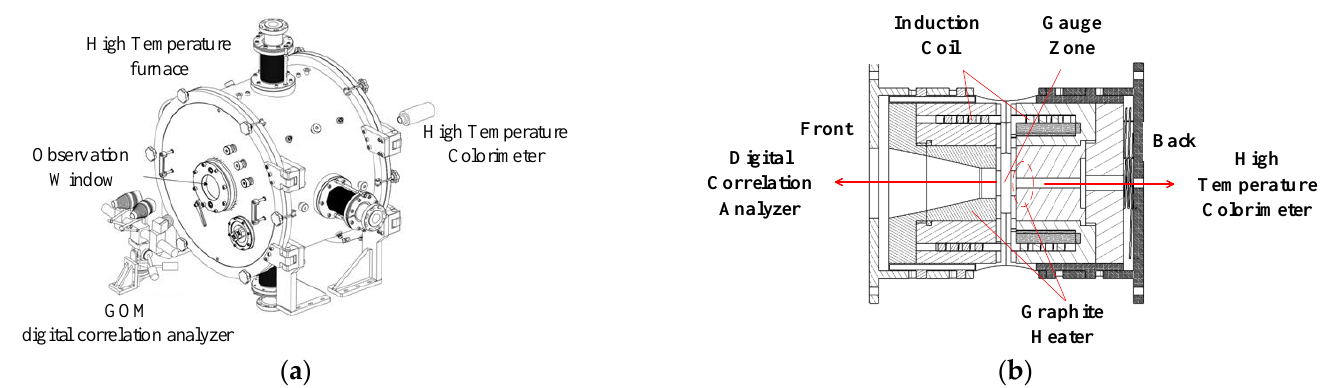
Figure 11. Schematic diagram of in situ observation. ( a ) Equipment placement position; ( b ) window limit size simulation.